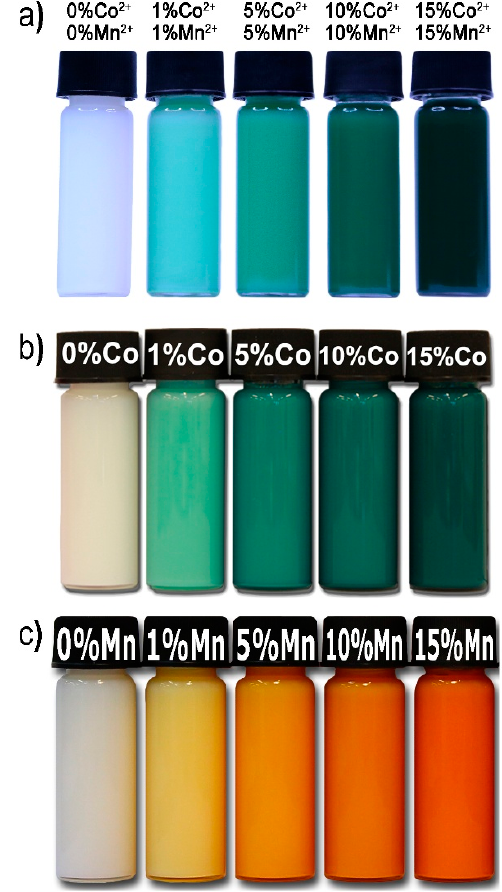
Figure 7. Photos of NP suspensions in ethylene glycol immediately after microwave solvothermal synthesis: ( a ) Zn (1 − x − y) Mn x Co y O, ( b ) Zn (1 − y) Co y O [150], ( c ) Zn (1 − x) Mn x O [149].